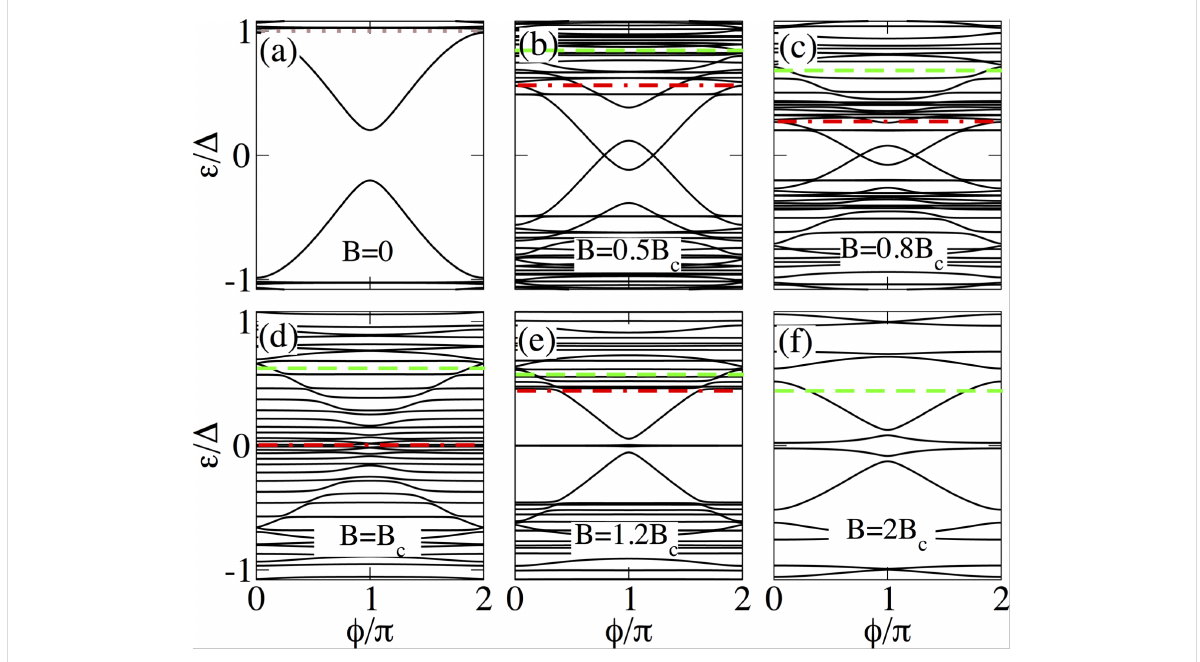
Figure 4: Low-energy Andreev spectrum as a function of the superconducting phase difference in a short SNS junction with L N = 20 nm and L S = 2000 nm. Different panels show the evolution with the Zeeman field: trivial phase for B < B c (a–c), topological transition at B = B c (d), and in the topological phase for B > B c (e,f). The energy spectrum exhibits the two different gaps that appear in the system for finite Zeeman field (marked by red and green dashed horizontal lines). Note that after the gap inversion at B = B c , two MBSs emerge at the ends of the junction as almost dispersion- less levels (outer MBSs), while two additional MBSs appear at = π (inner MBSs). Parameters: α R = 20 meV·nm, μ N = μ S = 0.5 meV and Δ = 0.25 meV.